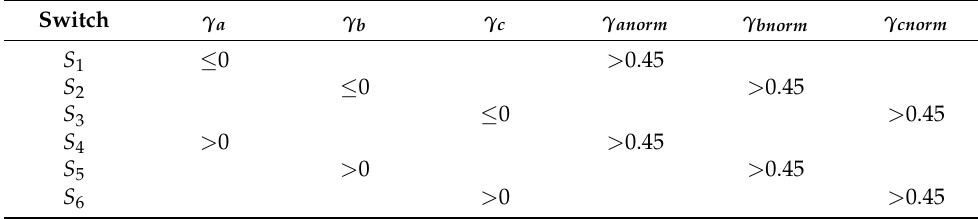
Table 3. Open-circuit Fault Detection.